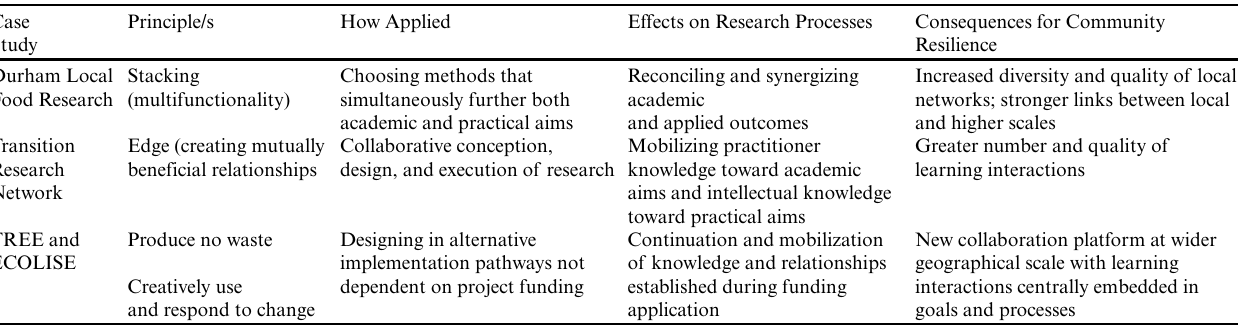
Table 1 . Applications of permaculture principles in research design and consequences for community